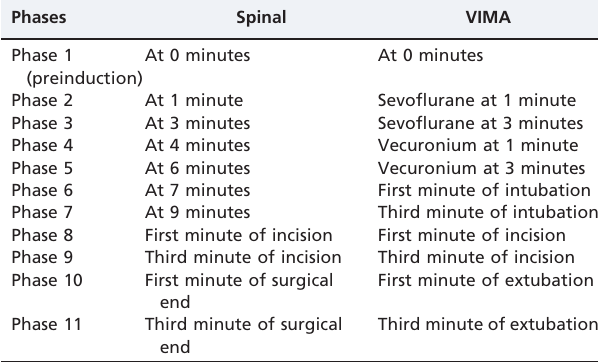
Table 1 - Measurement phases in VIMA and spinal anesthesia.